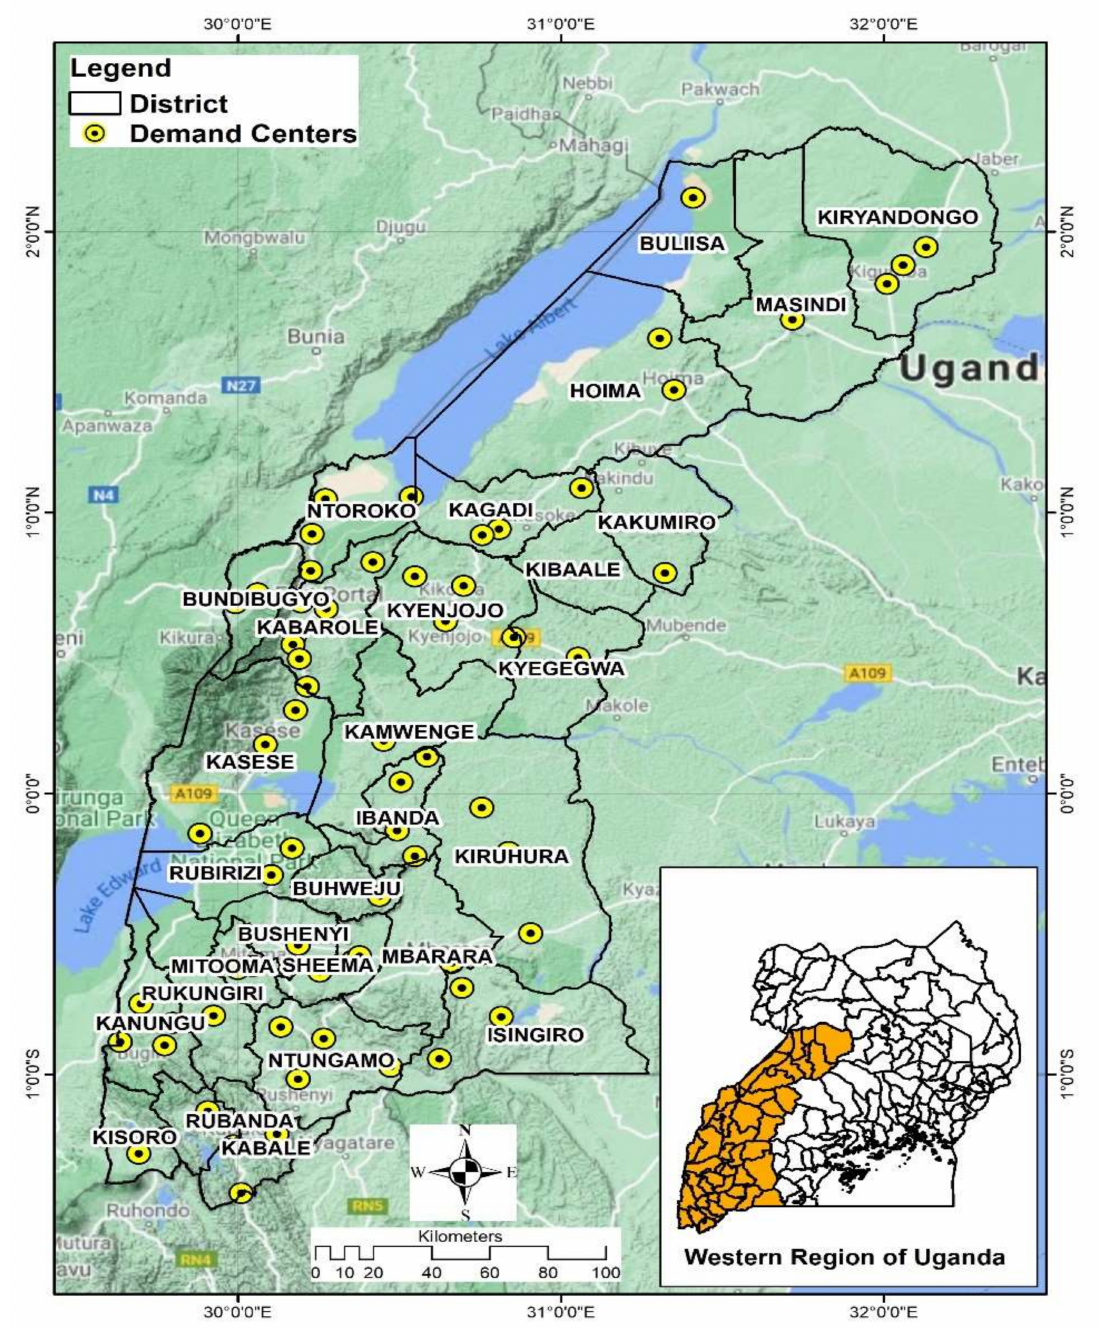
Figure 9. Map showing demand centers in the study